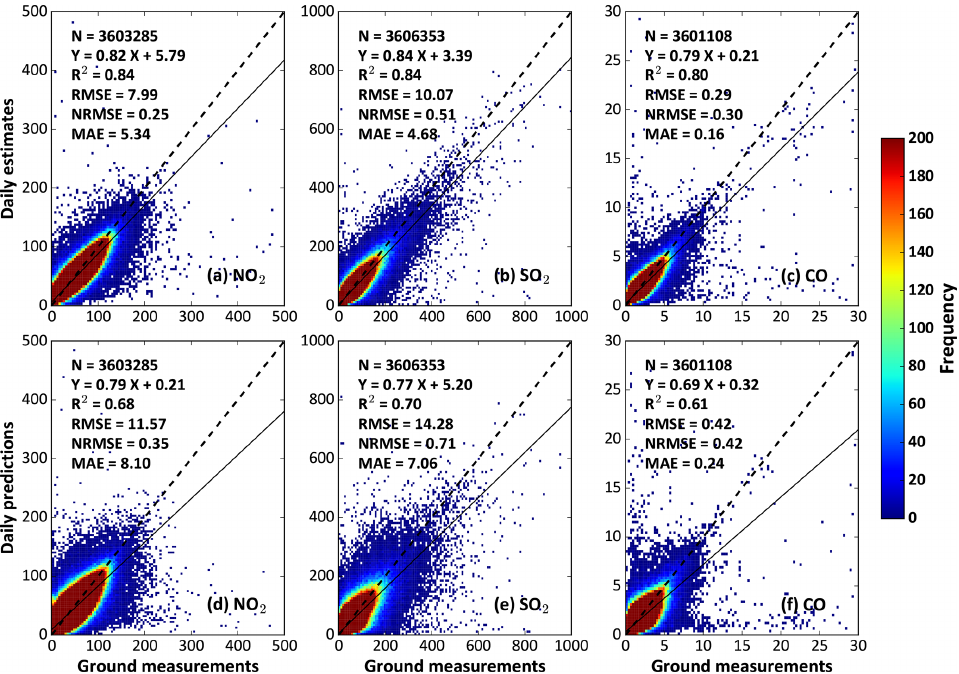
Figure 10. Density plots of daily (a–c) estimates and (d–f) predictions of ground-level NO 2 (µgm − 3 ), SO 2 (µgm − 3 ), and CO (mgm − 3 ) concentrations as a function of ground measurements in China from 2013 to 2020 using the out-of-sample (a–c) and out-of-station (d–f) cross-validation methods. Table 1. Statistics of the overall accuracies and predictive abilities of ambient gaseous pollutants for each year in China from 2013 to 2020. Year